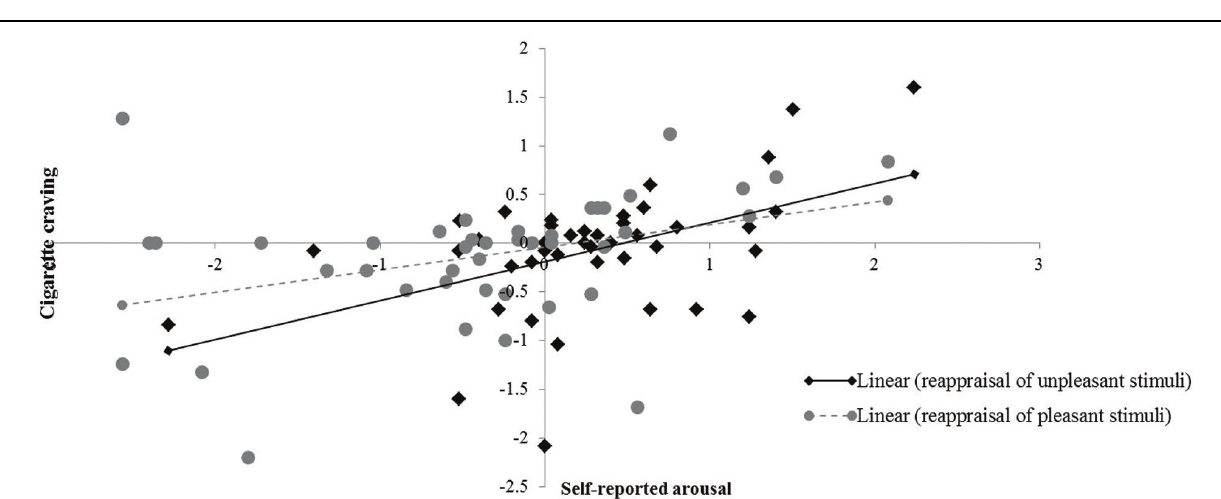
FIGURE 5 | Correlation between emotional arousal and cigarette craving. X -axis represents changes in self-reported arousal between reappraisal conditions (i.e., decrease-positive, decrease-negative) and corresponding ‘maintain’ conditions (i.e., maintain-positive, maintain-negative). Y -axis represents changes in cigarette craving as a function of